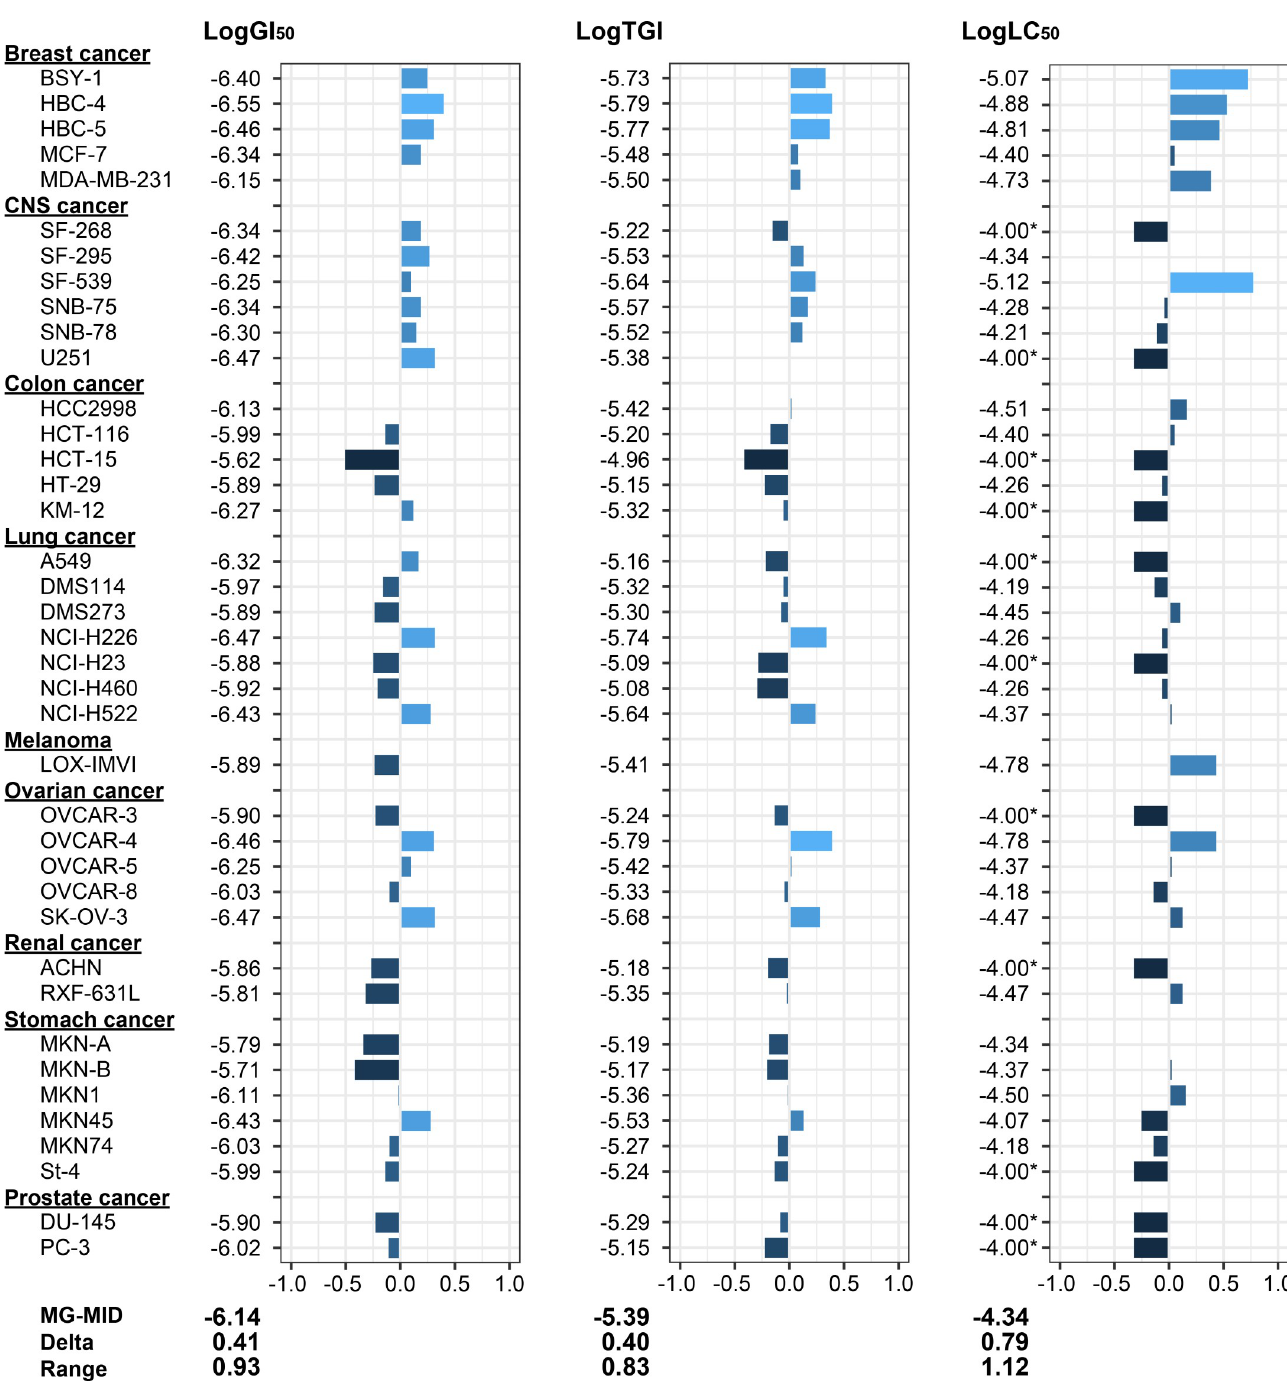
PLOS ONE | https://doi.org/10.1371/journal.pone.0218190 June 10,